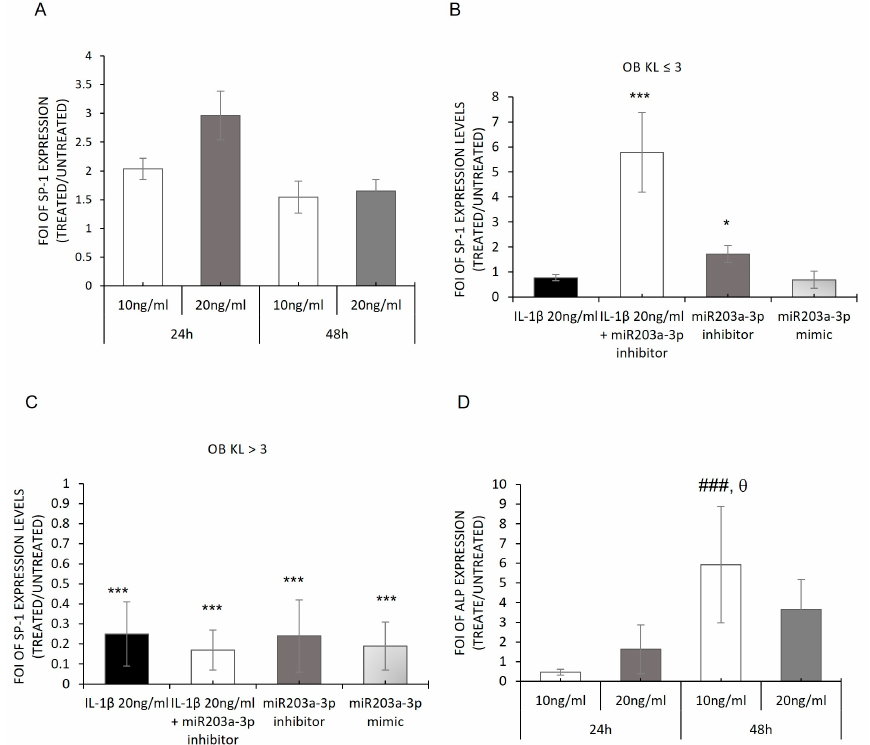
Figure 7. SP-1 expression: from hMSCs treated with IL-1 β to gain and loss of function study on OBs derived from OA patients. qRT-PCR analysis of SP-1 mRNA expression on hMSCs treated with IL- 1 β (10 ng/mL and 20 ng/mL) for 24 h and 48 h ( A ) and on OB-OA-derived KL ≤ 3 ( B ) and KL > 3 ( C ) groups treated with IL-1 β miR203a-3p inhibitor, and miR203a-3p mimic and after co-treatments IL-1 β and miR203a-3p inhibitor. qRT-PCR analysis of ALP expression on hMSCs treated with IL-1 β (10 ng/mL and 20 ng/mL) for 24 h and 48 h ( D ). Data are expressed as fold of induction (FOI) in gene expression (2 −ΔΔ Ct ) occurring in treated vs. scrambled untreated groups (mean ± SD, n = 4). Two-way (SP1: treatment effect, F = 31.82, p < 0.0005; experimental time effect, F = 10.64, p = 0.004; ALP: treatment and experimental time interaction, F = 6.52, p = 0.007) and one-way ANOVA ( SP1 , KL ≤ 3: F = 39.58, p < 0.0005; KL > 3: F = 30.23, p < 0.0005); multiple comparisons (one symbol, p < 0.05; two symbols, p < 0.005; three symbols, p < 0.0005) versus : *, OB; θ , untreated 48 h; # IL-1 β 10 ng/mL 24 h.